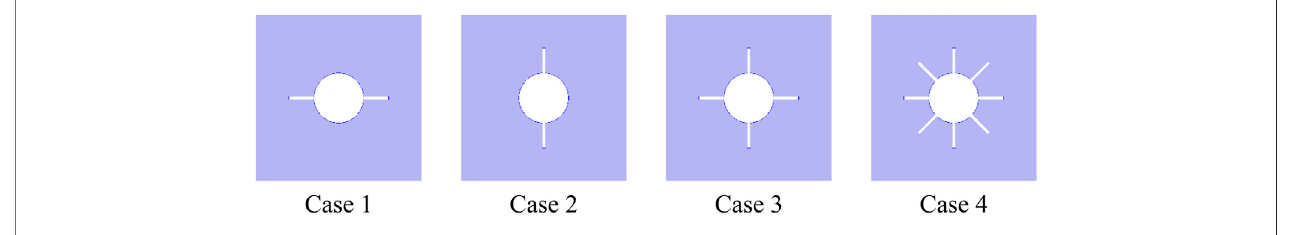
FIGURE 2 | Different cases of branched fi ns.